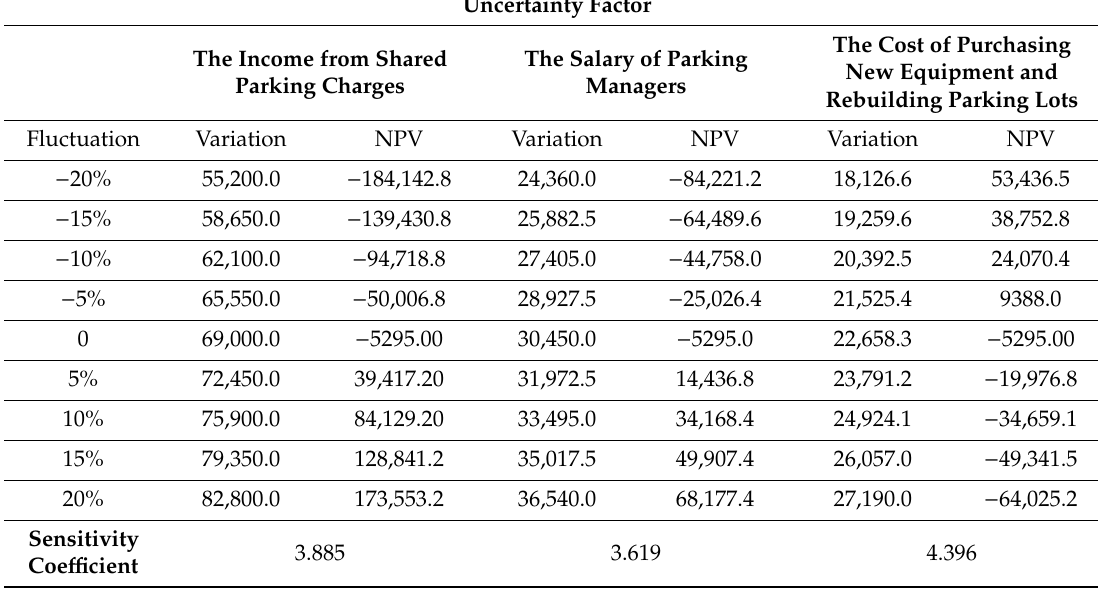
The statistics of variation of the uncertainty factor, net present value (NPV), and sensitivity coe ffi